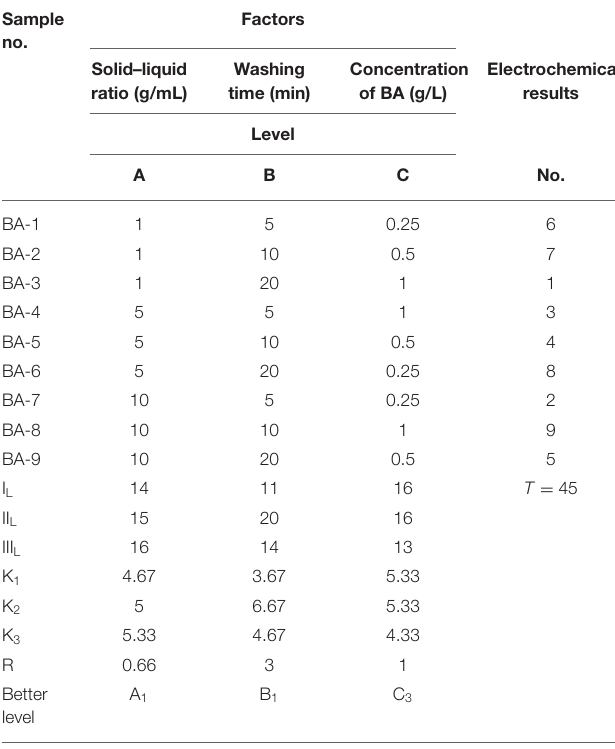
TABLE 3 | Orthogonal factor level table of washed samples based on the electrochemical performance of stored materials at 0.2C rate. Sample